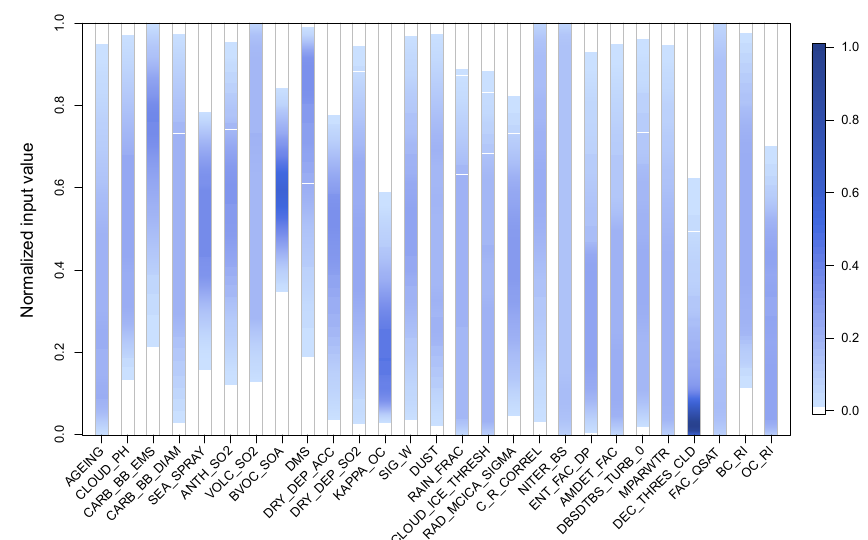
Figure 9. One-dimensional projection of the remaining parameter space after simultaneous constraint of all atmospheric quantities and decadal trends. The colour-scale shows the marginal normalized sampling density (normalized across parameters) of each input parameter over its range. Parts of the marginal parameter space that are effectively ruled out are shown in white (normalized sampling density < 0 .